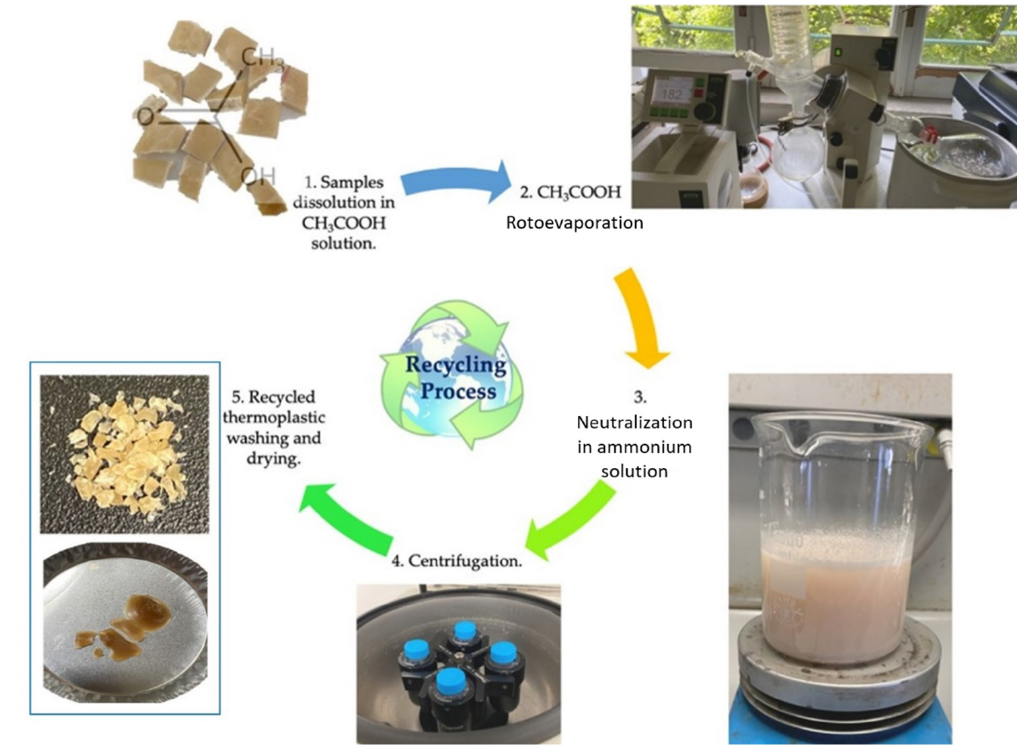
Figure 2. Chemical recycling process’s main steps.